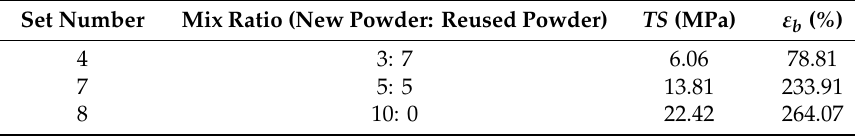
Table 6. Average tensile test results of the specimens.